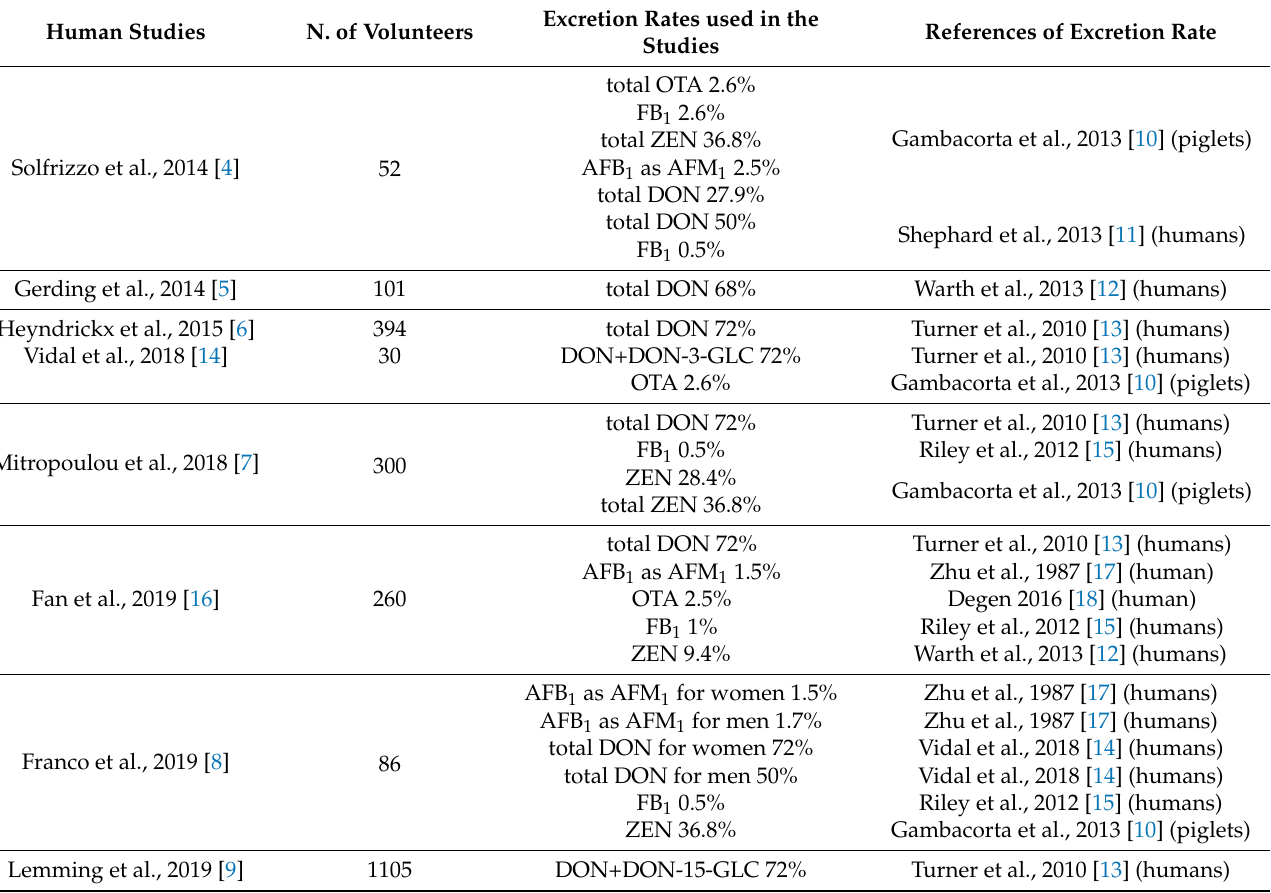
Table 1. Urinary excretion rates of mycotoxins used in human studies that assessed mycotoxin exposure from urinary mycotoxin